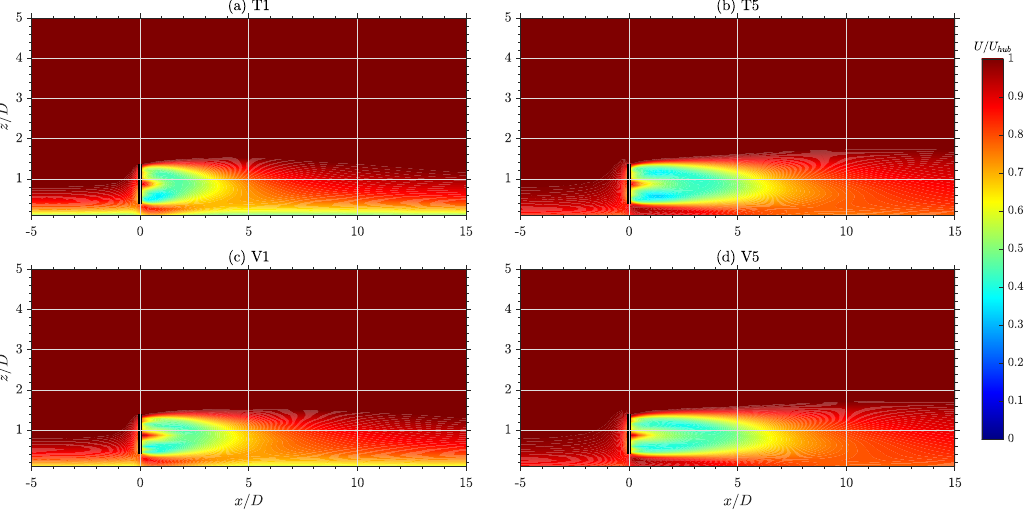
Figure 2. Contours of the normalized mean streamwise velocity ( U / U hub ) in the x − z plane, passing through the center of the turbine for ( a ) T1, ( b ) T5, ( c ) V1, ( d )